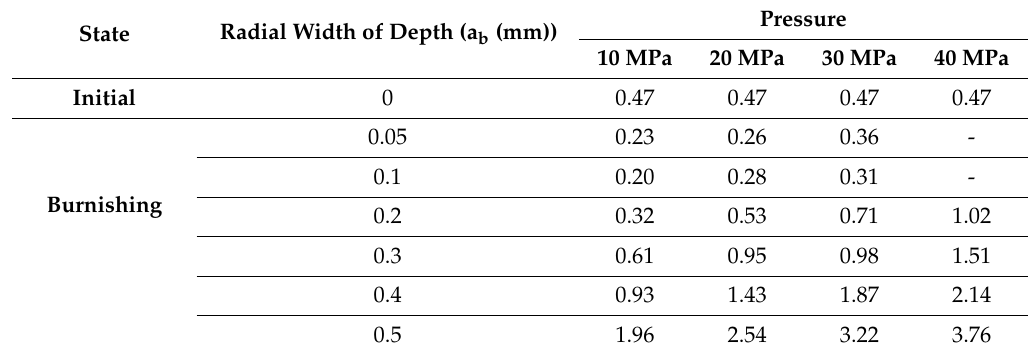
Table 2. Burnishing conditions and roughness values